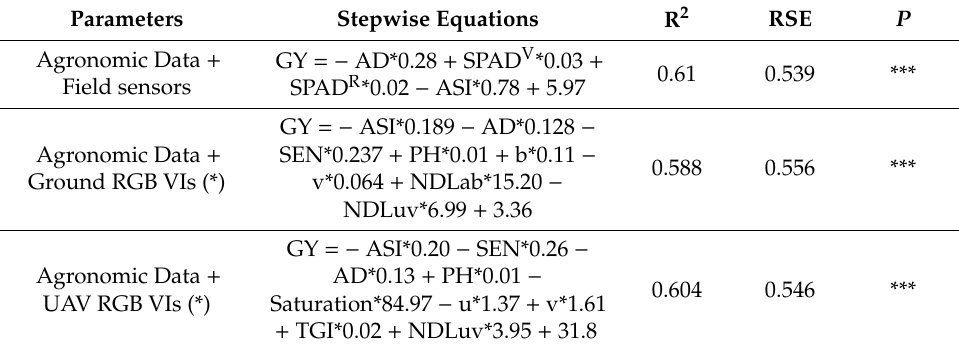
Table 6. Multilinear regressions (stepwise) of GY in LOW as the dependent variable comparing the di ff erent categories of remote sensing traits: UAV and ground RGB VIs (these indices are defined in Section 1), agronomic data such as ASI, AD, SEN, and PH, and NDVI and SPAD. R 2 ,